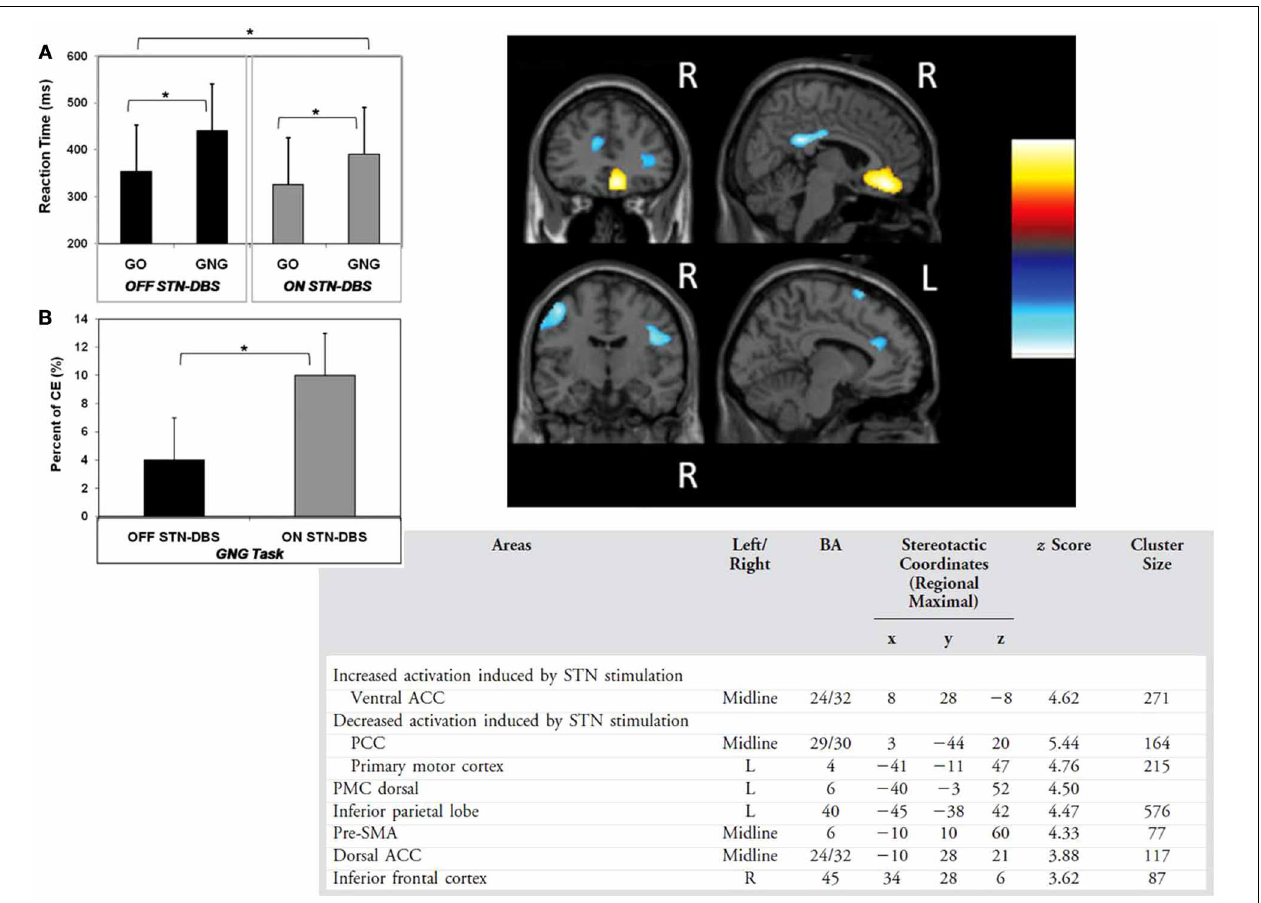
FIGURE 7 | (A) The reaction times for the go no go (GNG) and simple reaction time (GO) tasks (B) commission errors (CE) in the go no go task with subthalamic nucleus deep brain stimulation on or off (C) areas showing decreased and increased activation with